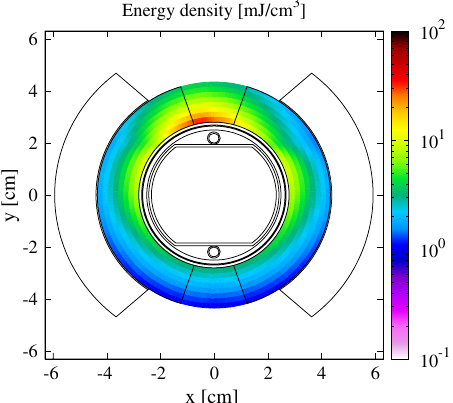
FIG. 6. Simulated transverse energy density distribution from FLUKA for the strong-kick event in MB.B10R2 coils at the position where the maximum energy deposition occurs. Results correspond to 2 × 10 9 protons impacting on the magnet beam screen. Spatial coordinates are with respect to the center of the vacuum